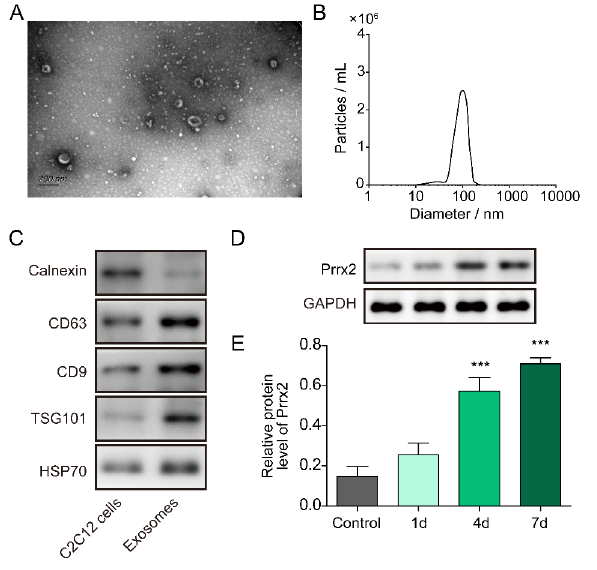
Fig. 1 Up-regulation of Prrx-2 in myoblast-derived exosomes. (A) C2C12 myoblasts-derived exosomes were observed by transmission electron microscopy. (B) The particle sizes of exosomes were analyzed. (C) West- ern blotting was performed to detect the expression of exosome mark- ers CD9, CD63, TSG101, HSP70 or endoplasmic reticulum marker Calnexin. (D&E) Prrx-2 level in isolated exosomes was evaluated by Western blotting. *** P <